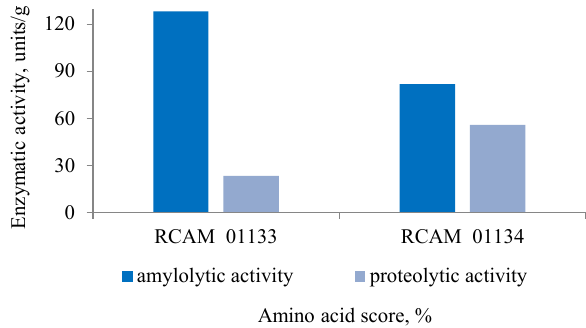
Figure 3 Enzymatic activity of Aspergillus oryzae strains,